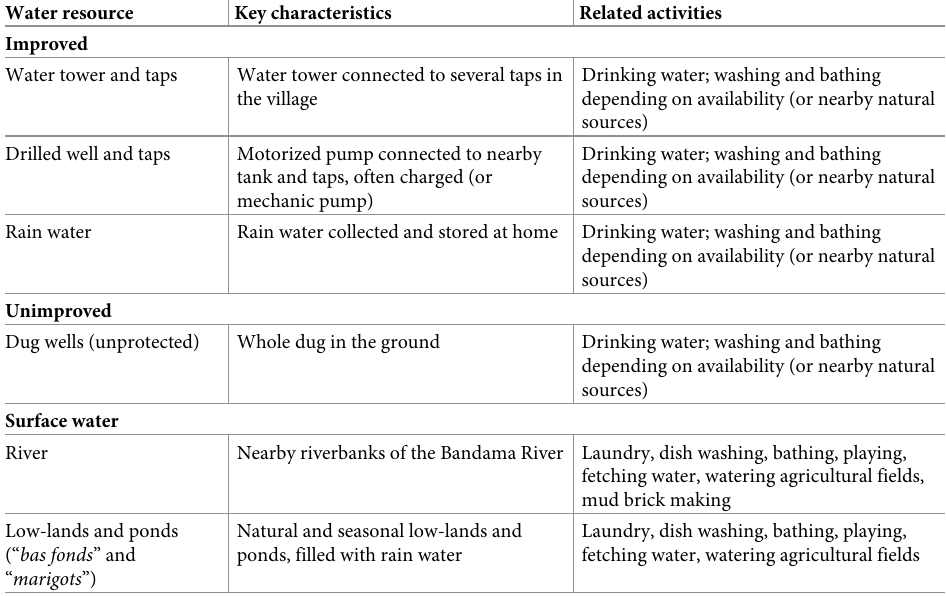
Table 3. Overview of water resources frequented by Buruli ulcer cases interviewed in the study area in south-cen- tral Coˆte d’Ivoire in late 2021/early 2022.